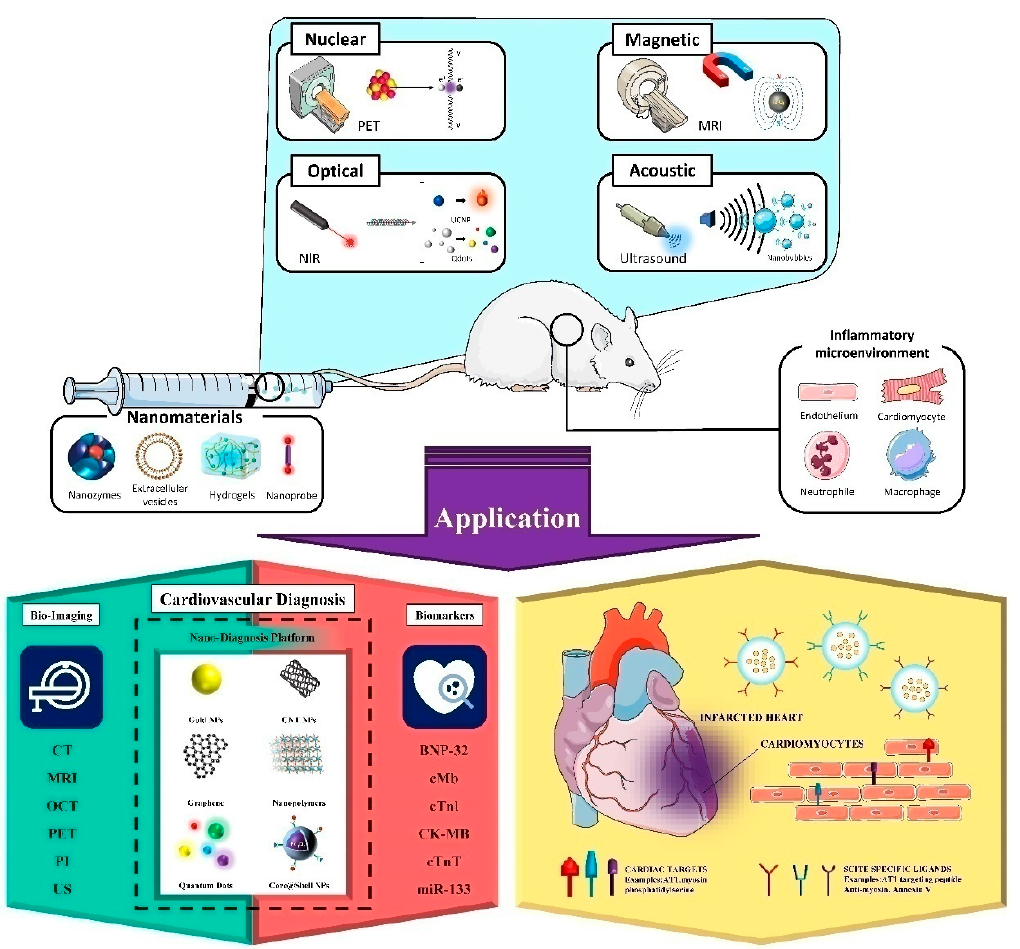
Figure 2. Application of nanotheranostics in the diagnosis and treatment of the myocardial inflam- matory microenvironment.